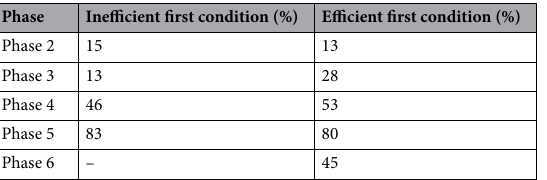
Table 2. The proportion of children reverting to their originally learned solution by condition and